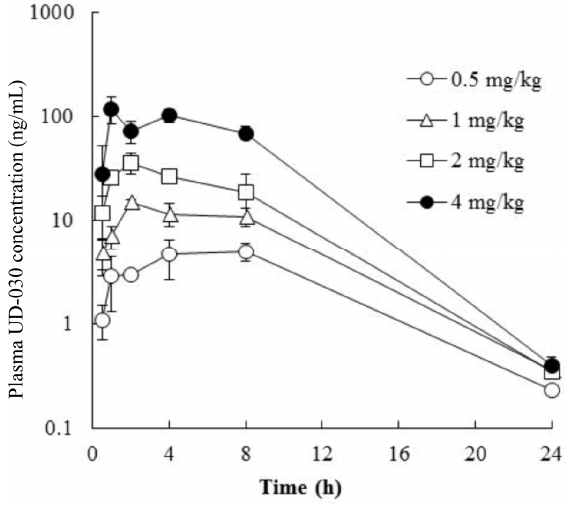
Figure 2. Plasma concentration vs. time profiles of UD-030. UD-030 was administered orally once in male mice over the dose range of 0.5 to 4 mg/kg. The data are expressed as the mean ± SD ( n = 3). Table 2. Plasma concentrations and pharmacokinetic parameters of UD-030 after a single oral administration.